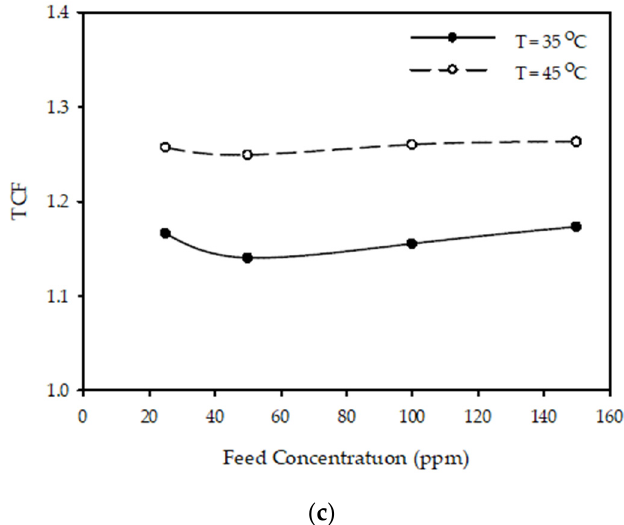
Figure 6. Effect of ( a ) pressure at (3.2 L/min, 100 ppm) ( b ) flow rate at (30 bar, 100 ppm) ( c ) feed concentration at (20 bar, 3.2 L/min) on TCF at different temperatures.